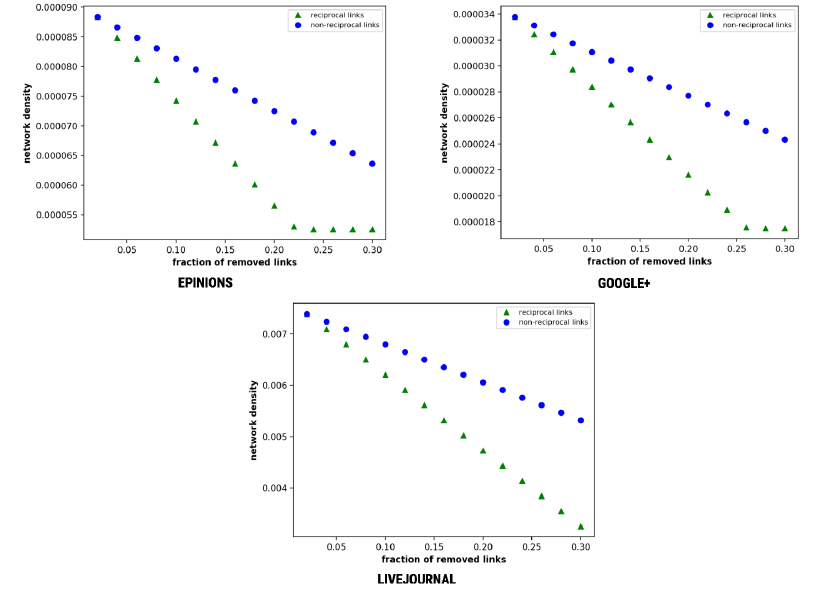
Figure 10. Affected network density as a function of the fraction of removed links.